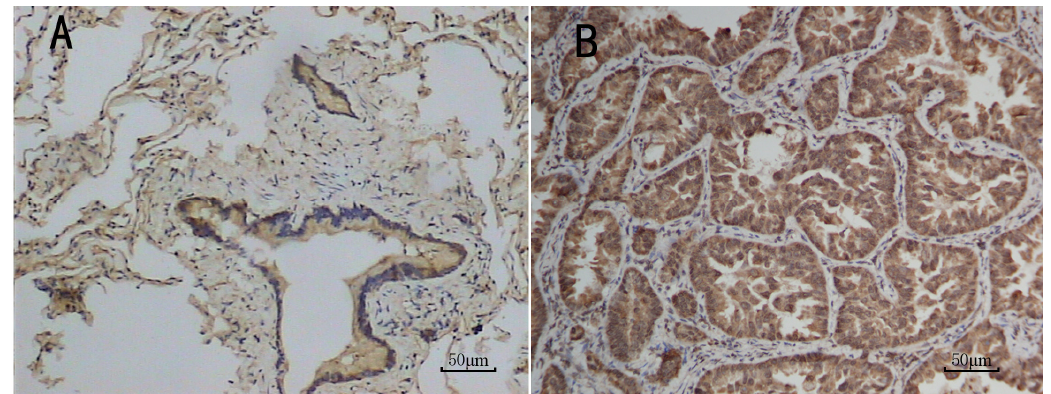
Figure 3. Immunohistochemical analysis of CHRNA3 protein in normal lung and lung ADC tissue, showing a cytoplasmic staining pattern. In normal lung tissue, immunoreactivity was detected in alveolar and bronchial cells ( A , ×200); In ADC, immunoreactivity was detected in tumor cells, but not in stromal cells ( B , ×200).